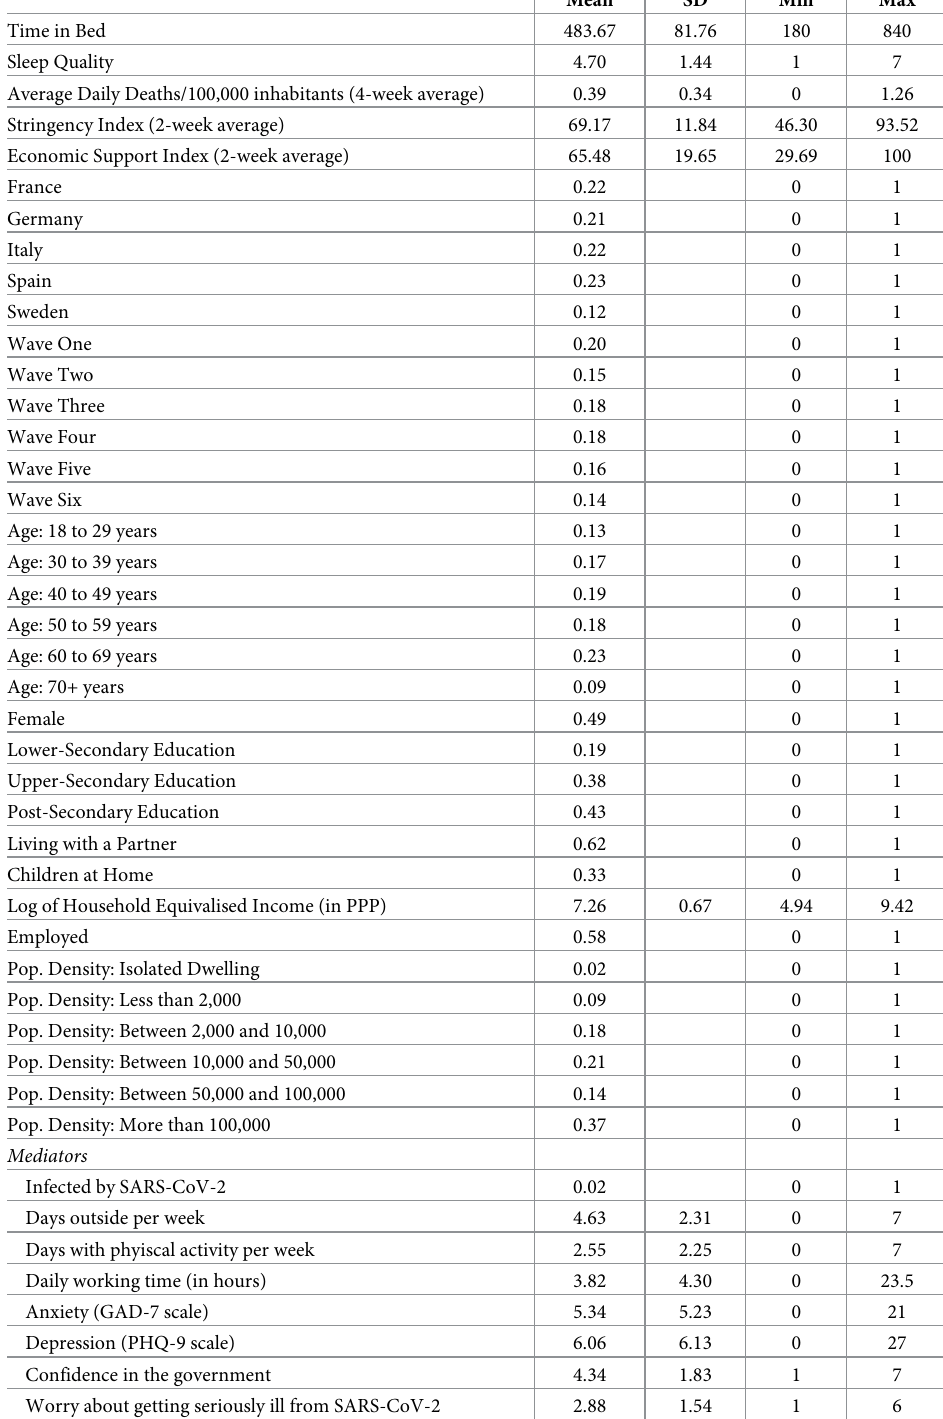
Table 1. Descriptive statistics–estimation